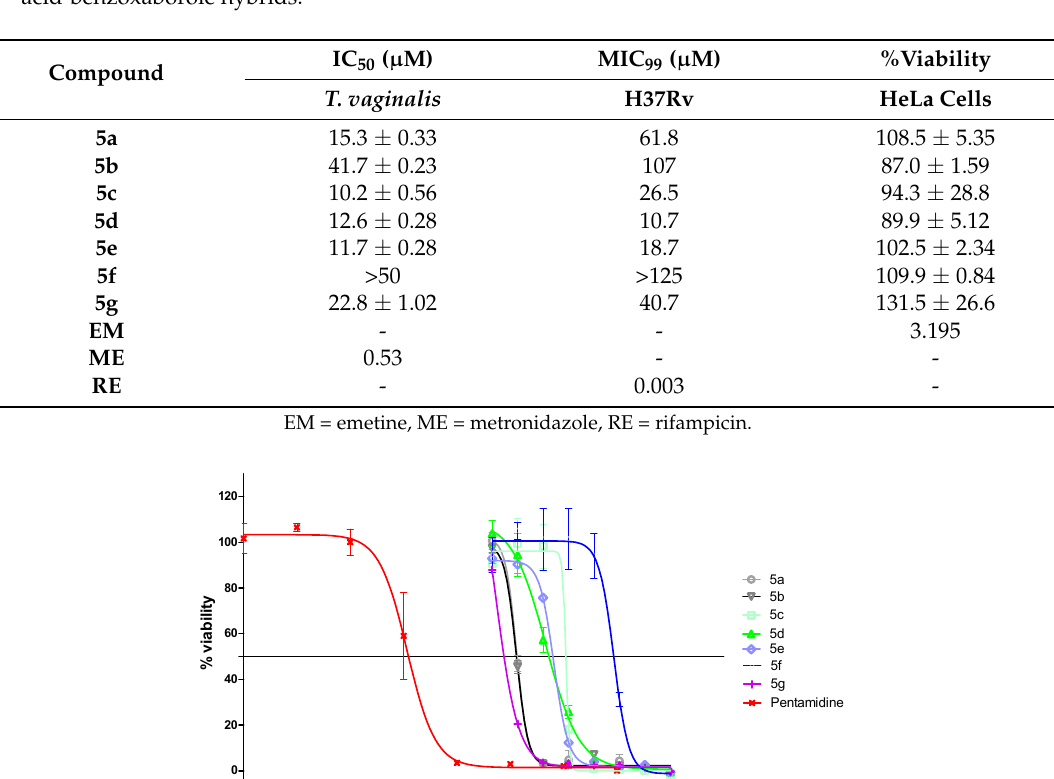
Table 1. In vitro antimycobacterial, antitrichomonas, and cytotoxicity activities of cinnamic acid-benzoxaborole hybrids.